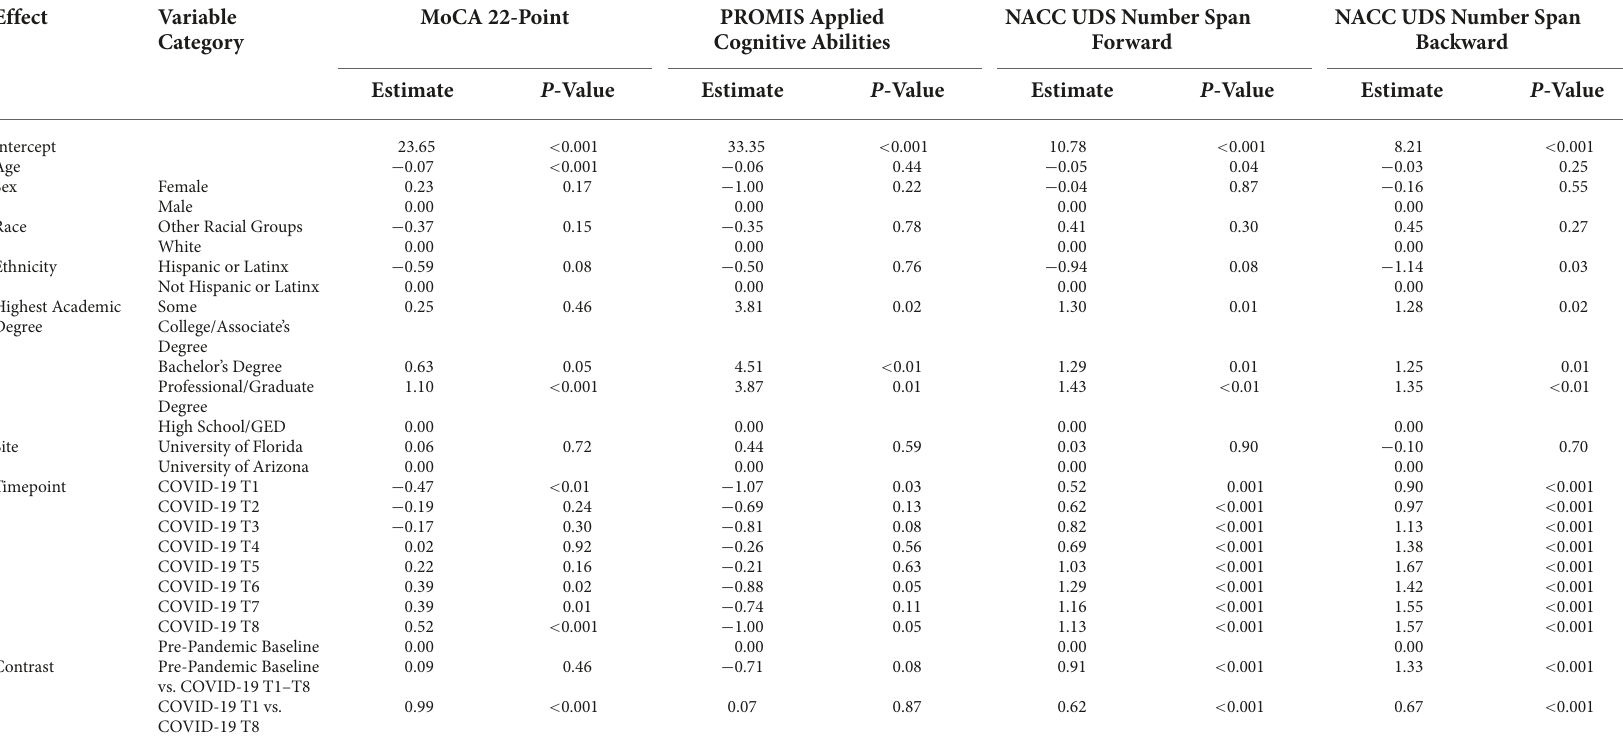
TABLE 5 Cognitive functioning